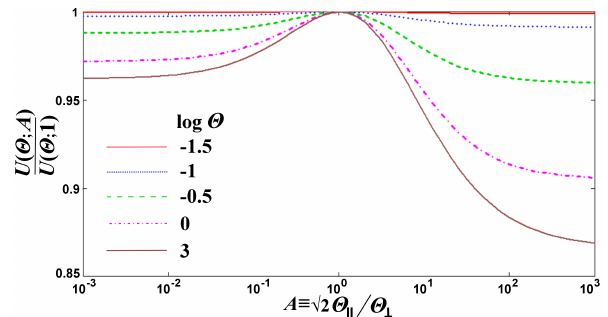
Figure 4. The internal energy depends on the anisotropy A , maxi- mized in the case of isotropic temperature, A = 0. At the classical limit of (cid:50) → 0, i.e., for c → ∞ , the internal energy becomes inde- pendent of the temperature directional components (cid:50) i